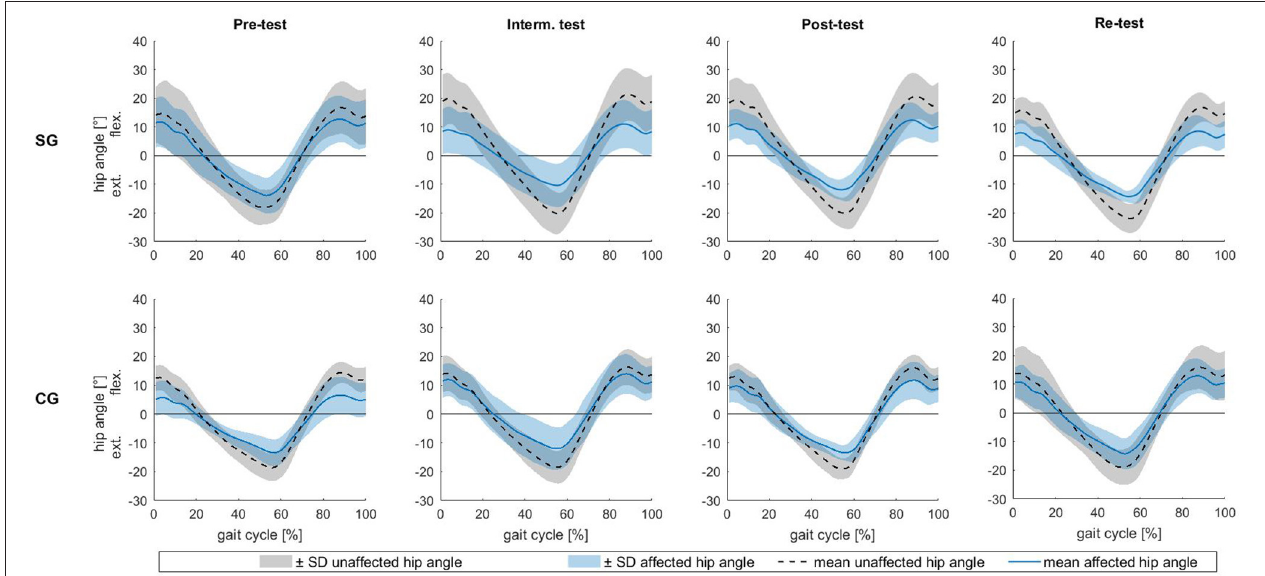
FIGURE 3 | Hip joint angle over a gait cycle normalized to 100%. The lines (black: unaffected leg, blue: affected leg) are mean values. The shaded area above the line is the mean + 1 SD, the shaded area below the line is the mean − 1 SD. The upper row shows the results of the sonification group (SG), the bottom row shows the results of the control group (CG) for the four test